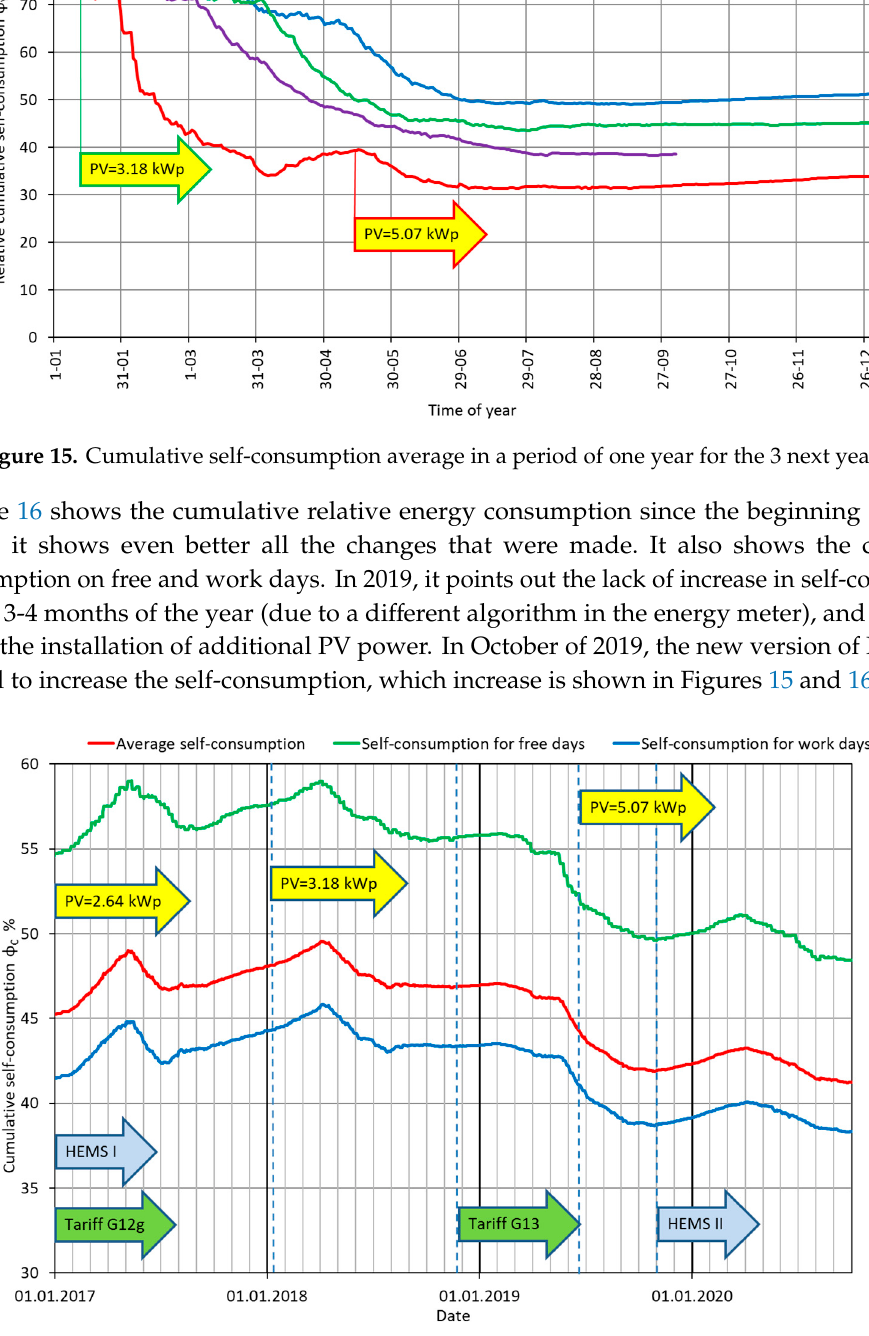
Figure 14. Relative self-consumption as a function of daily generation with PV divided into work and free days.